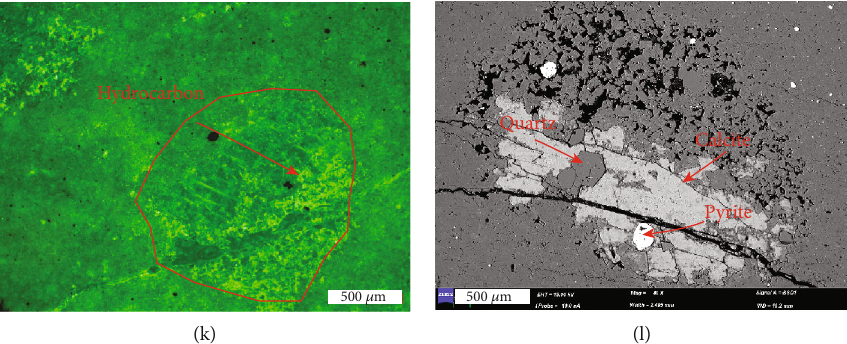
Figure 4: Minerals fi lling in anhydrite dissolution pores of the Ordovician carbonate in Yican 1 well in the southeastern Ordos Basin. (a) Anhydrite nodule-bearing dolomite in Yi14 well, 2298.6m, Ma 51 . (b) Anhydrite dissolution pores in the core of Yican 1 well, 2635m, Ma 51 . (c) Anhydrite dissolution pores fi lled with dolomite, calcite, and pyrite in Yican 1 well, 2642.5m, Ma 51 , sample 96. (d) Anhydrite dissolution pores fi lled with dolomite, calcite, and quartz, 2641.4m, Ma 51 , sample 92. (e) Anhydrite dissolution pores fi lled with dolomite, calcite, and pyrite, 2642.5m, Ma 51 , sample 96. (f) Ultraviolet fl uorescence photo shows hydrocarbon inclusions enriched in dolomite at the bottom of the nodule and lattice defect of calcite at the top of nodule, 2642.5m, Ma 51 , sample 96. (g) Saddle dolomite showing undulose extinction in the anhydrite dissolution pores, 2951.5m, Ma , sample 242. (h) Calcite with crossed twinning and euhedral quartz 2 fi lling in anhydrite dissolution pores, 2641.4m, Ma 51 , sample 92. (i) Anhydrite dissolution pores fi lled with calcite and quartz, 2642.5m, Ma 51 , sample 96. (j) Anhydrite dissolution pores fi lled with dolomite and calcite, 2640.9m, Ma 51 , sample 90. (k) Ultraviolet fl uorescence photo shows hydrocarbon inclusions enriched in dolomite at the bottom of the nodule and lattice defect of calcite at the top of nodule, 2640.9m, Ma 51 , sample 90. (i) SEM photo of calcite, pyrite, and quartz fi lling in the anhydrite dissolution pores, 2641.4m, Ma 51 , sample